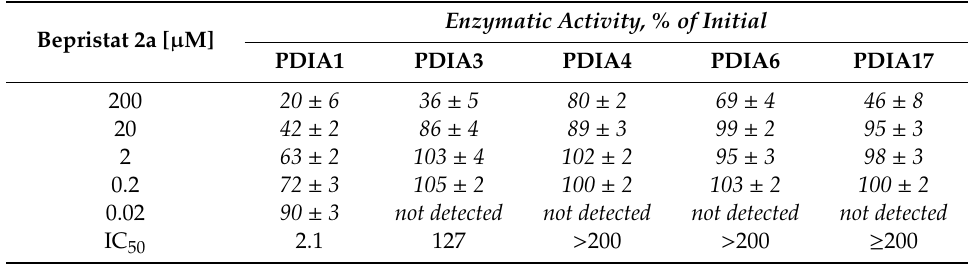
Recombinant PDIA1, PDIA3, PDIA4, PDIA6 and PDIA17 enzymes were incubated with bepristat 2a at various concentrations (0.02–200 µ M) for 60 min at 37 ◦ C, and then the activity of enzymes was monitored in